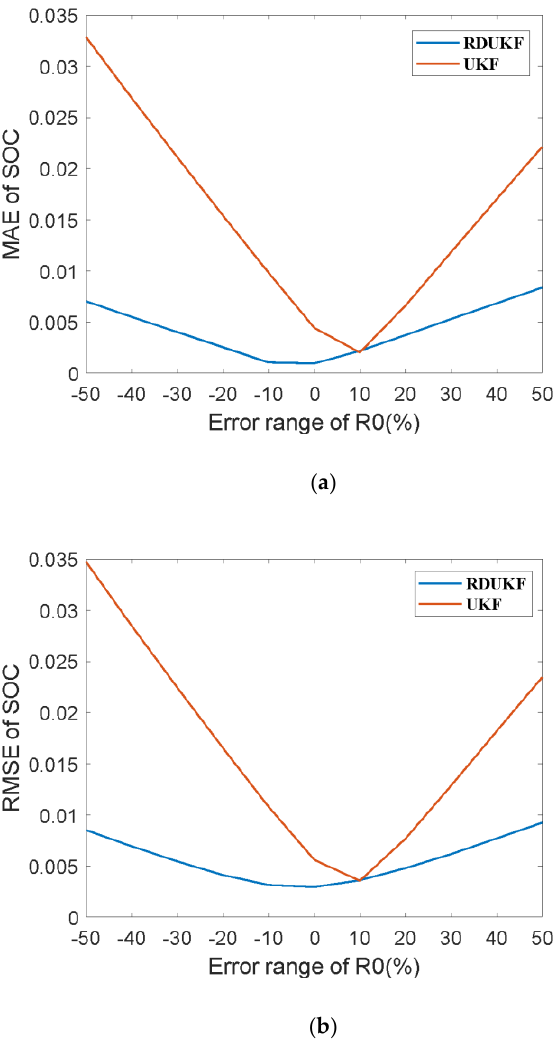
Figure 9. ( a ) MAE according to deviations in R0; ( b ) RMSE according to deviations in R0.